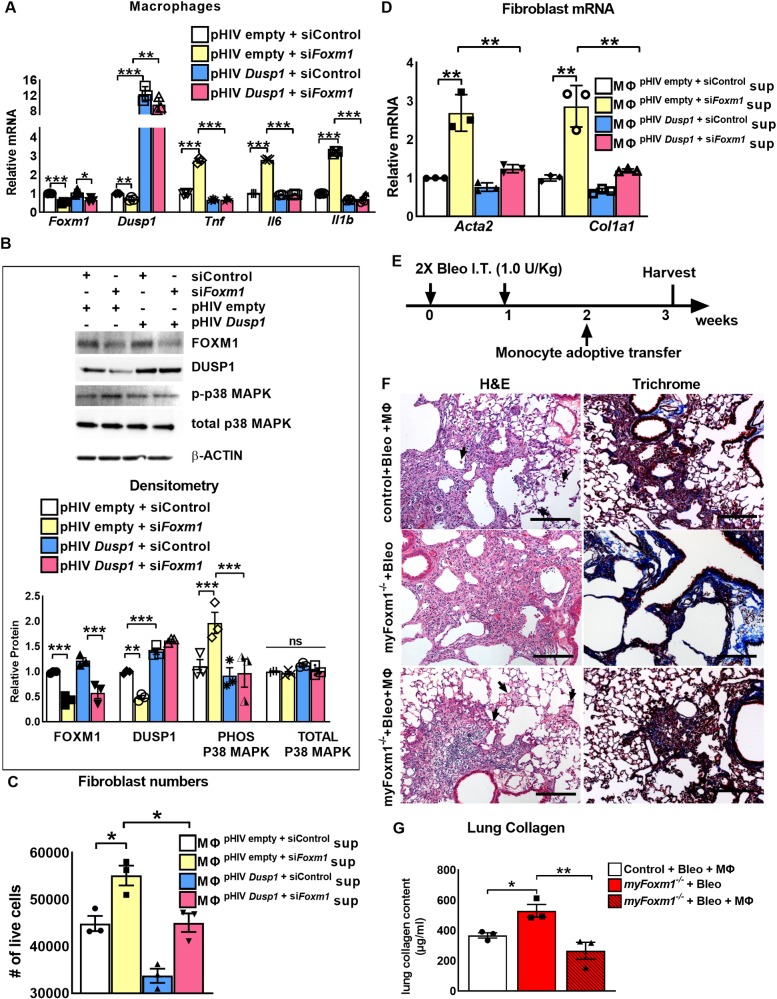
Adoptive transfer of wild-type macrophages reduces lung fibrosis in myFoxm1-/- mice.(A) Overexpression of Dusp1 decreases expression of Tnf, Il6 and Il1b in FOXM1-deficient macrophages. RAW264.7 macrophages were co-transfected with non-targeting siRNA (siControl) or siFoxm1, and pHIV-empty vector or pHIV-Dusp1. mRNAs were analyzed by qRT-PCR. Overexpression of Dusp1 decreased Tnf, Il6 and Il1b mRNAs in siFoxm1 transfected macrophages as shown by qRT-PCR. Actb mRNA was used for normalization (n = 3). (B) Overexpression of Dusp1 in FOXM1-deficient macrophages decreases activation of p38 MAPK pathway. RAW264.7 macrophages were co-transfected with non-targeting siRNA (siControl) or siFoxm1, and pHIV-empty vector or pHIV-Dusp1 and protein levels were analyzed by Western blot. Expression of DUSP1 in Foxm1-depleted RAW264.7 macrophages decreased phospho-p38 MAPK protein levels. No changes were detected in total p38 MAPK protein levels. β-ACTIN was used as loading control. Graph shows densitometry quantification of Western blots. Protein levels were normalized to β-ACTIN. Protein expression is presented as fold change over pHIV empty + siControl transfected cells. Blots are representative of three independent experiments. (C-D) Supernatant from Dusp1 overexpressing Foxm1-deficient macrophages decreases fibroblast number and activation. 3T3 fibroblasts were cultured in supernatant obtained from RAW264.7 macrophages co-transfected with control siRNA or siFoxm1, and pHIV-empty vector or pHIV-Dusp1. 48 hours after transfection number of live cells were counted by trypan blue (n = 3). Expression of Acta2, Ccnd1, and Col1a1 mRNAs in fibroblasts was measured by qRT-PCR. Actb mRNA was used for normalization (n = 3). (E) Experimental design of adoptive transfer. (F) Representative H&E images (left) and trichrome images (right) show significant reduction in fibrosis in myFoxm1-/- mice upon adoptive transfer of FOXM1-expressing WT monocytes (n = 3 mice per group). Scale bar = 200μm. (G) Lung collagen content was measured using the Sircol assay and revealed that transfer of FOXM1-expressing WT monocytes into myFoxm1-/- mice significantly reduced bleomycin-induced lung fibrosis. * = P < 0.05, ** = P <0.01, *** = P < 0.001, by Student’s t-test.